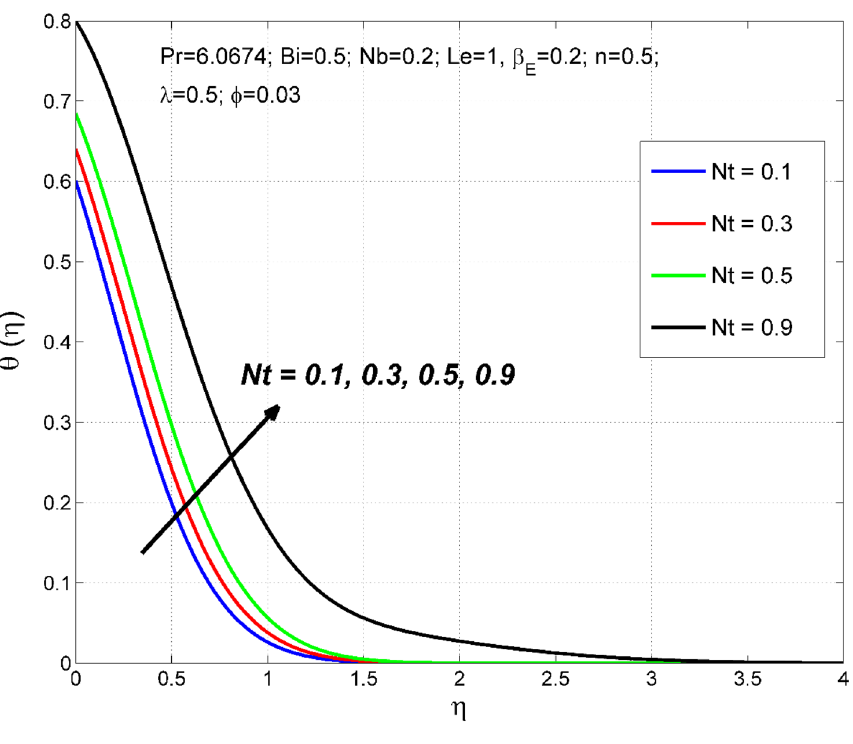
Figure 15. The temperature distribution θ (η) behavior for the variation of the thermophoresis Nt .